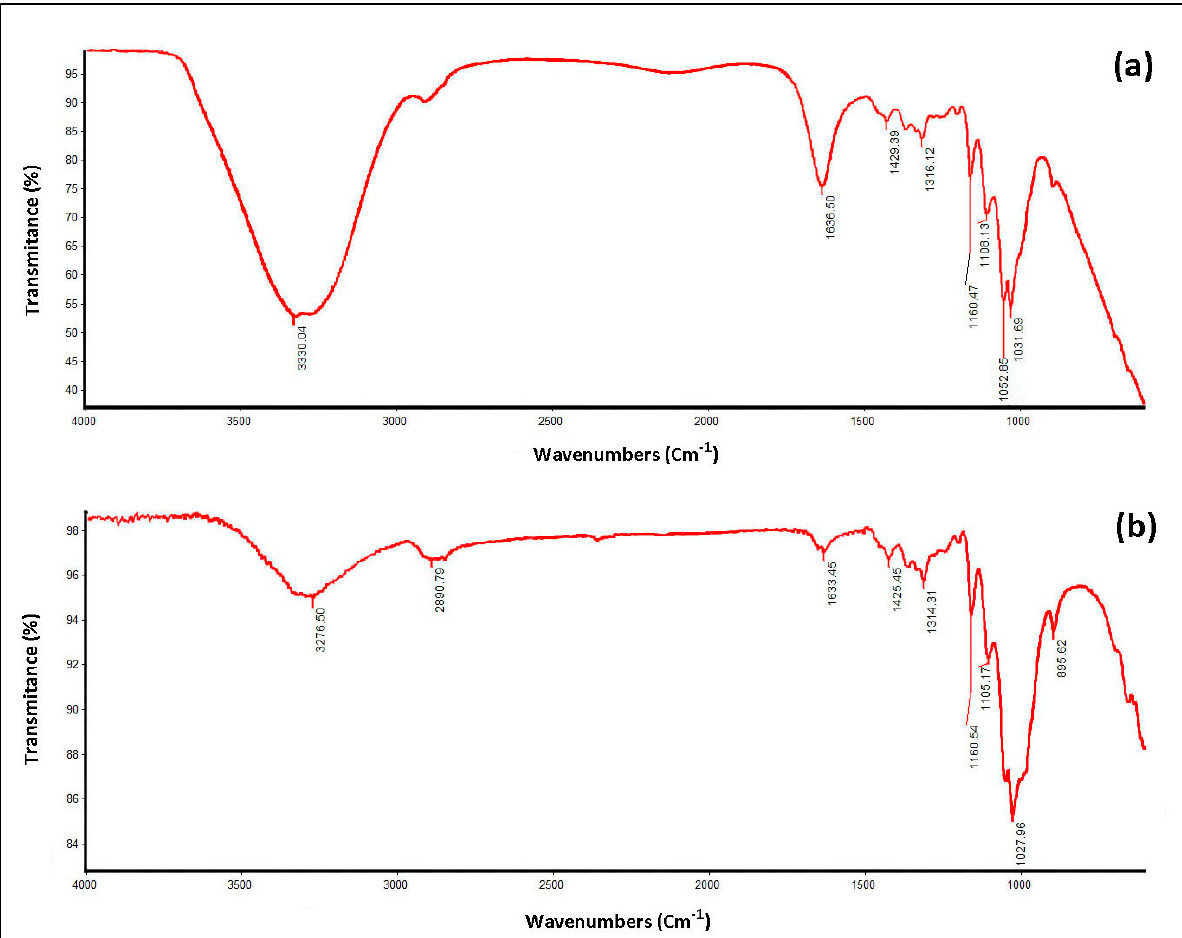
Figure 10. Fourier transform infrared spectra of the EFB ( a ) WEFB fibers and ( b ) SEFB fibers.